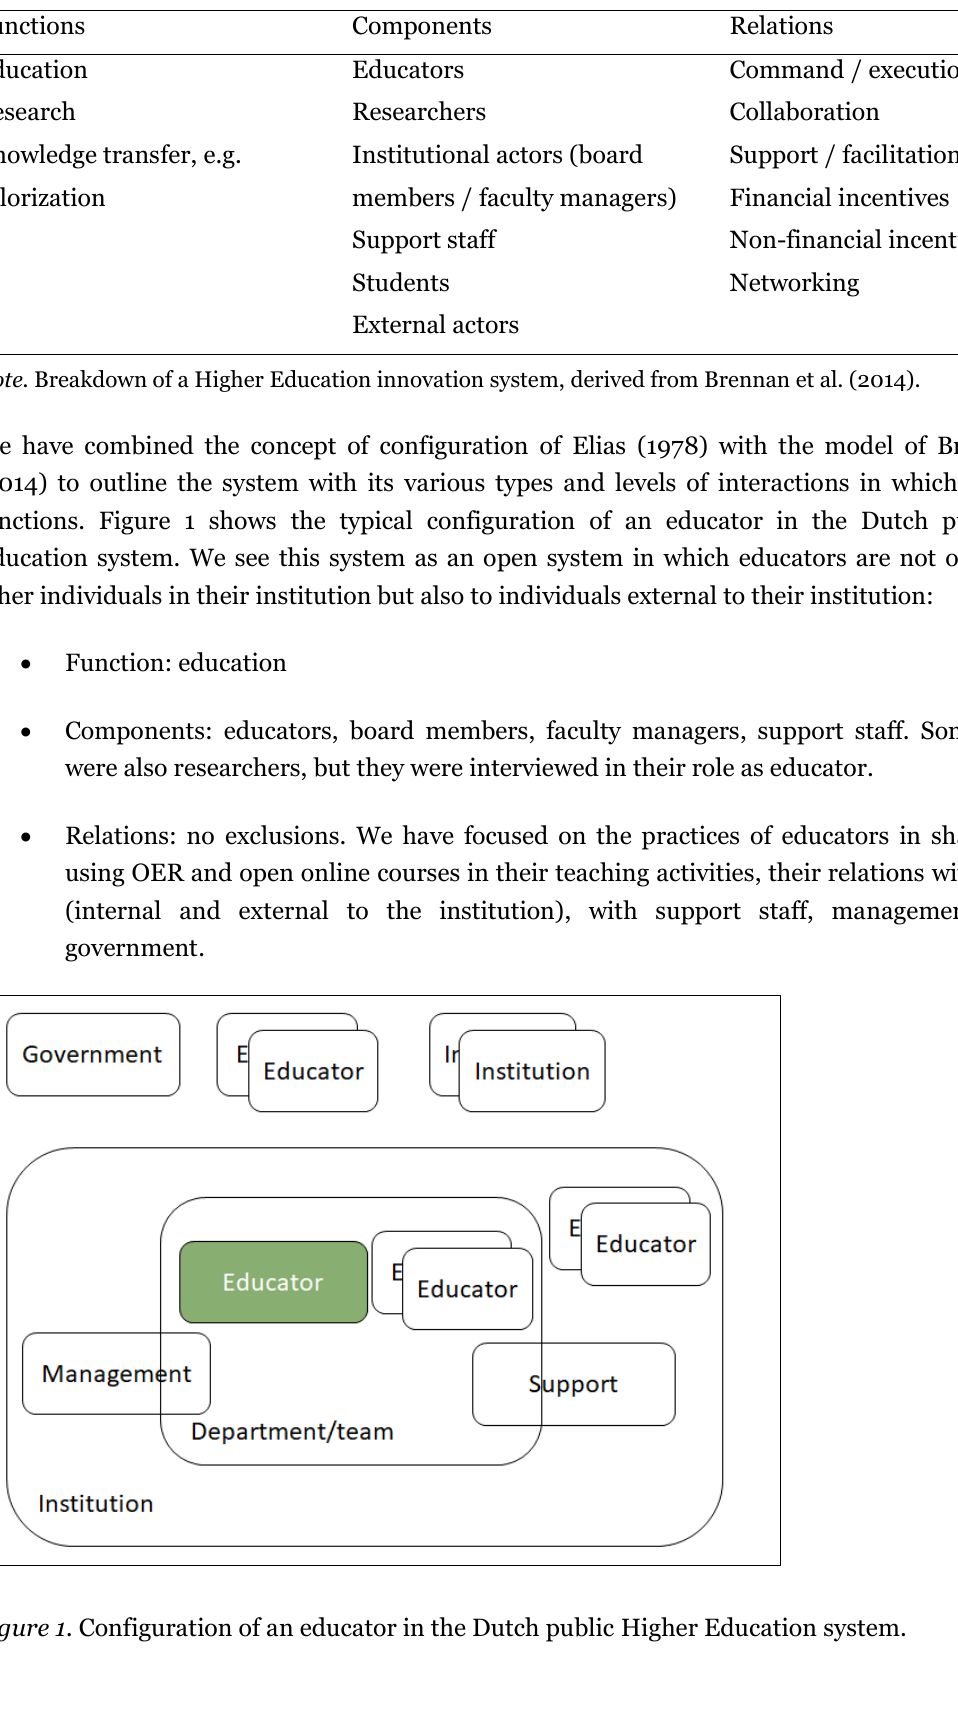
Higher Education Innovation System